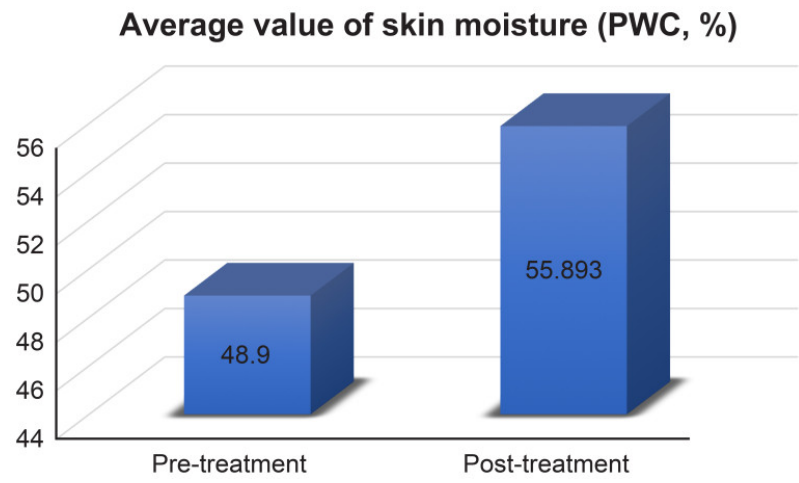
Figure 2. Average values of skin moisture measurement results. Pre-treatment 48.9 ± 4.126%, post-treatment 55.893 ± 3.371%.